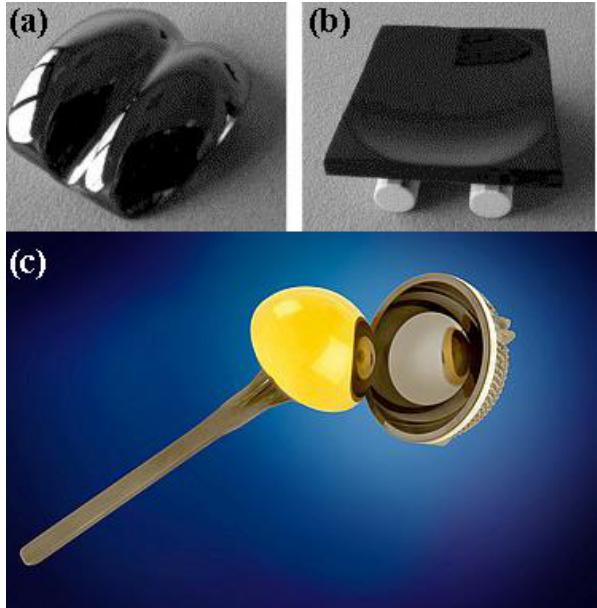
Figure 34. DLC-coated artificial joints. ( a ) Talar and ( b ) tibial components of an ankle joint, both